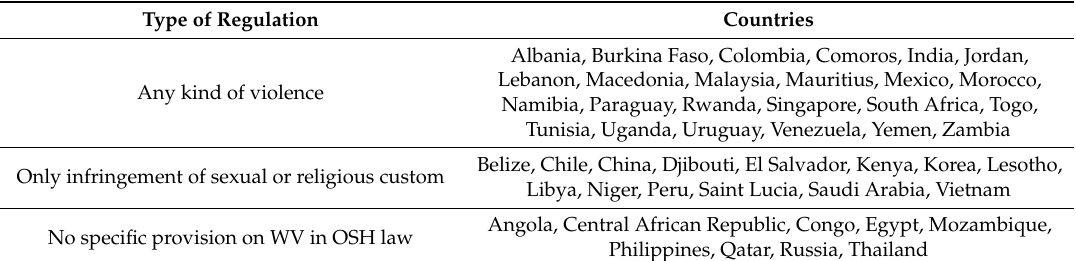
Table 3. Examples of di ff erences in the regulation of workplace violence among developing and transition